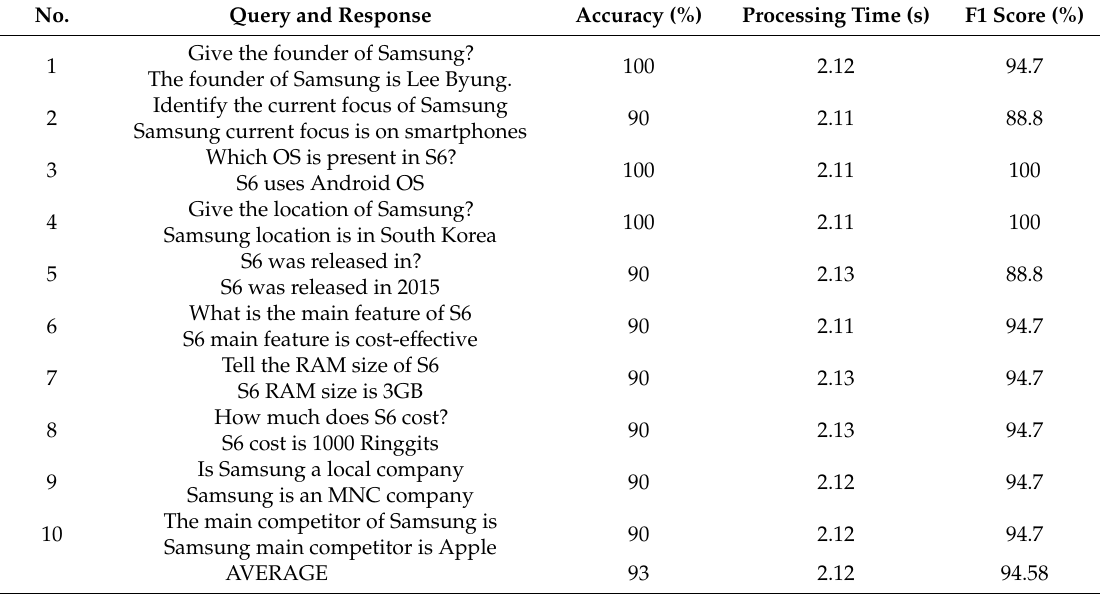
Table 5. F1 score of process-based system.